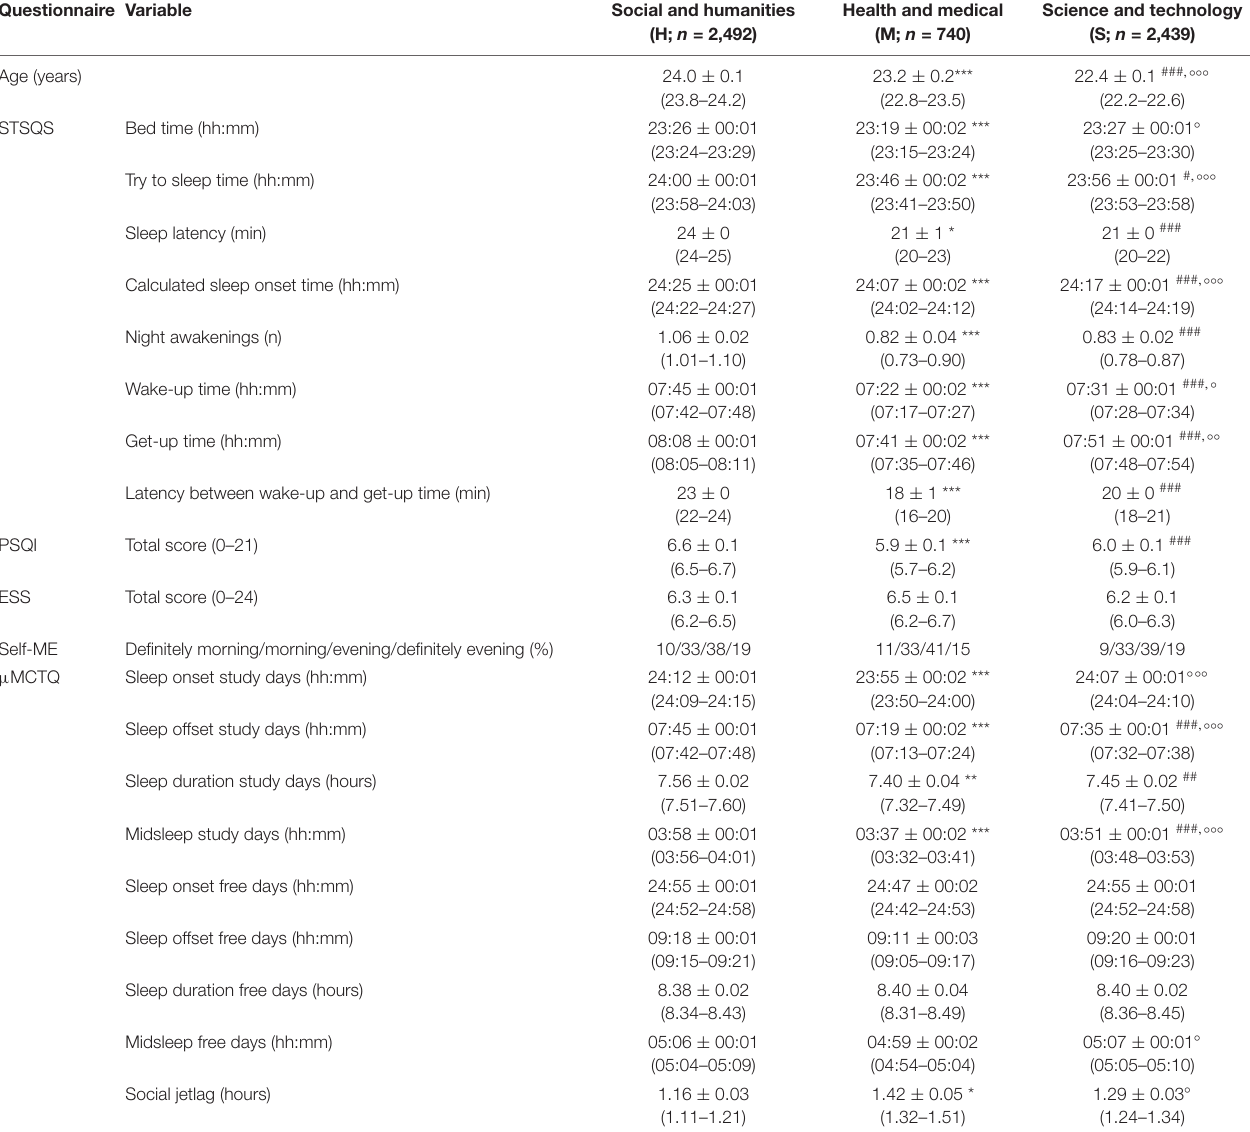
TABLE 2 | Sleep–wake indices [mean ± SE (95% CI)] on joining the initiative at T0, by study subject. Questionnaire Variable Social and humanities